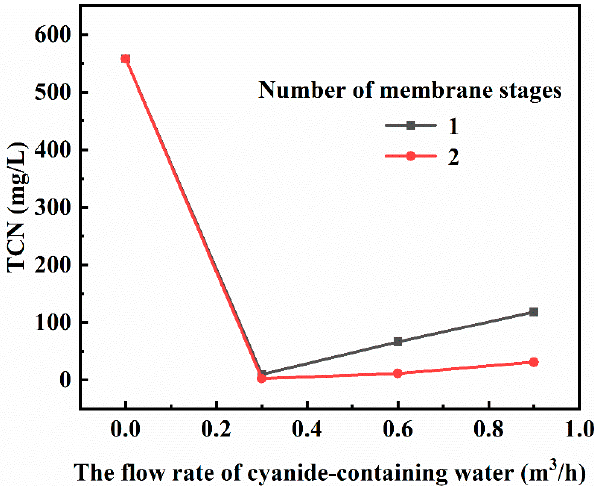
Figure 12. Effect of the flow rate of cyanide-containing water on the membrane treatment process.